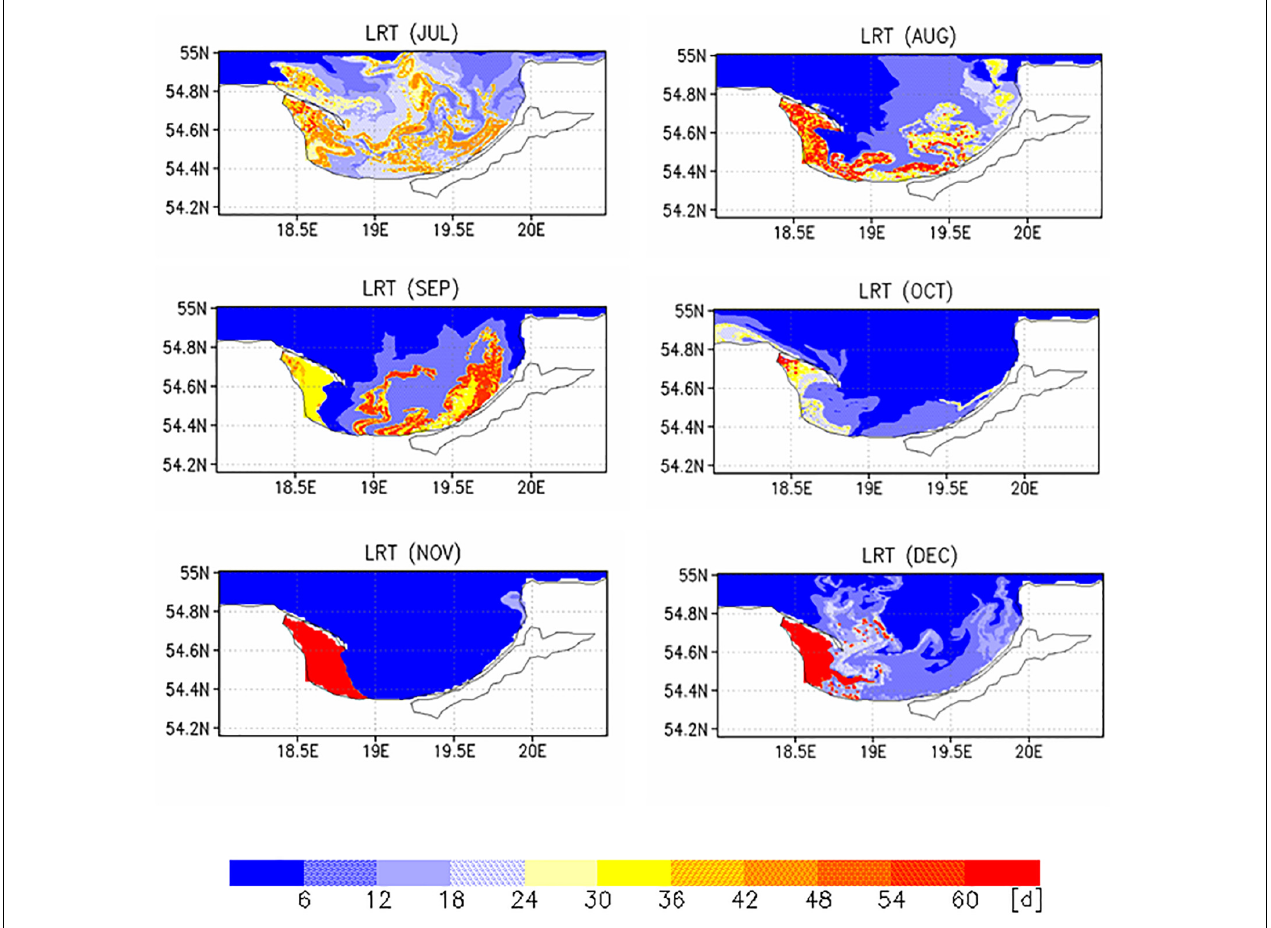
FIGURE 7 | Lagrangian residence time (LRT) in days for July to December